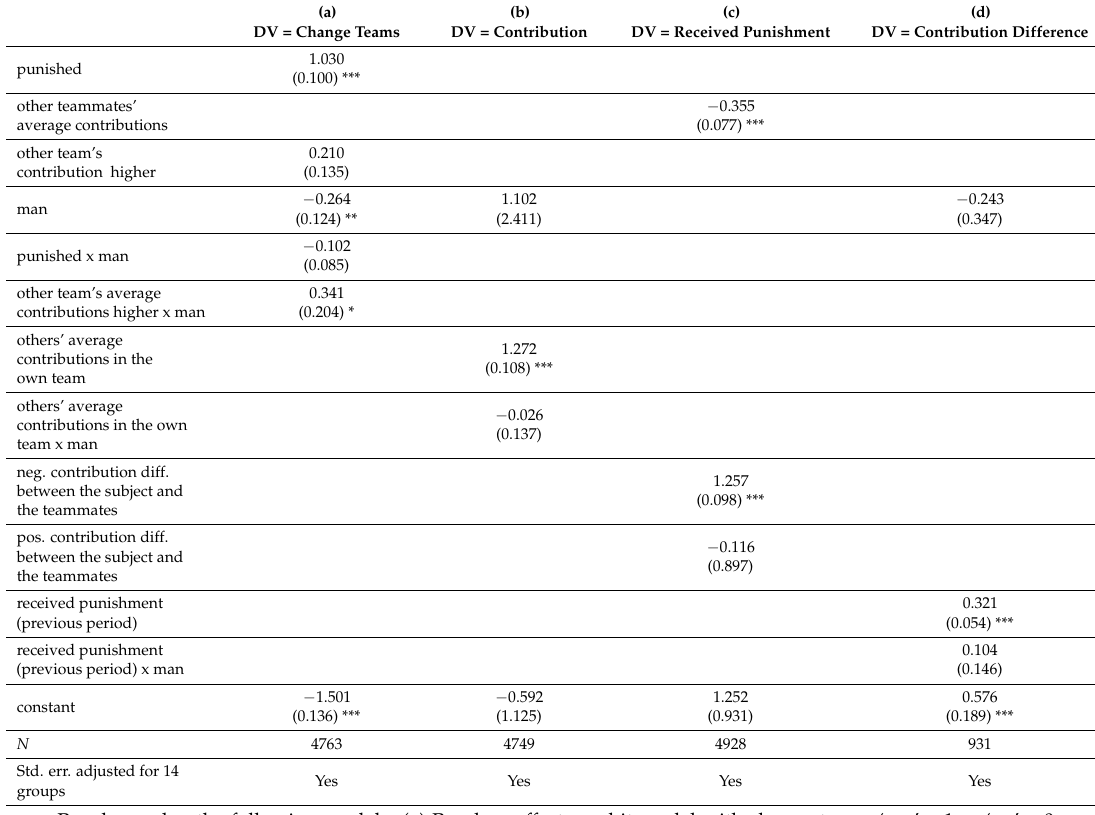
Table 1. Regression results on (a) team change behavior; (b) conditional cooperation; (c) received punishment; and (d) reaction to